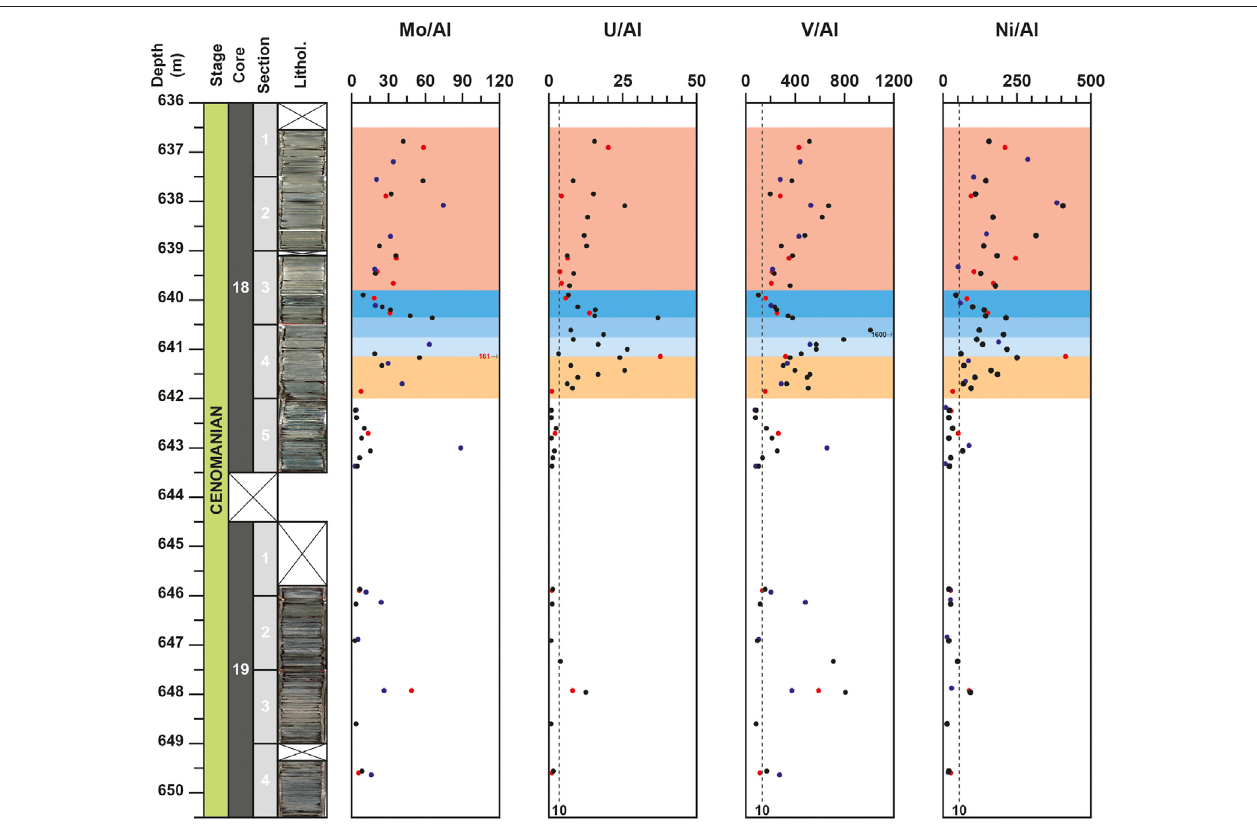
FIGURE 4| Depth-pro fi les for Mo/Al, U/Al, V/Al, Ni/Al for the DSDP site 367, Data from the studies of Kuypers et al. (2002), coupled to unpublished data from H-J. Brumsack on the same samples, and Westermann et al. (2014) are represented with blue and red circles respectively.Vertical black dotted line, noted 10, represent the El/Al values corresponding to an EF equal to 10, respectively compared to the Upper Continental Crust (McLennan, 2001): 0.19 for Mo/Al; 0.35 for U/Al; 13.31 for V/Al and 5.47 for Ni/Al.